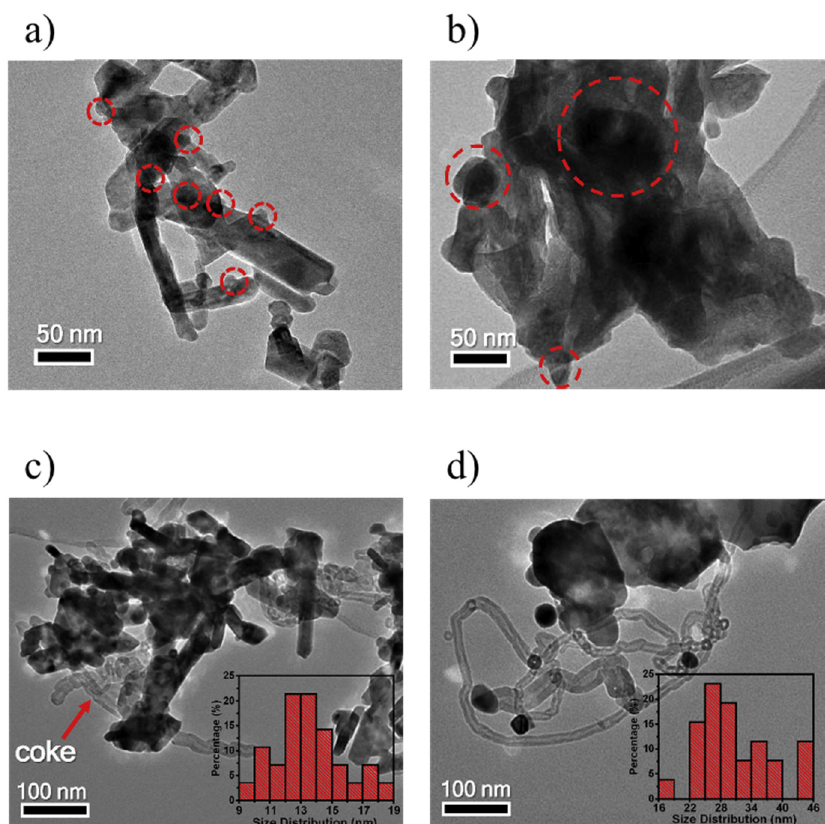
Figure 6. TEM image of ( a ) Ni nanoparticles synthesized on La 2 O 3 nanorod (denoted as 5Ni/La 2 O 3 ‐ LOC in Ref. [60]) and ( b ) on La 2 O 3 supports via a wet impregnation method (denoted as